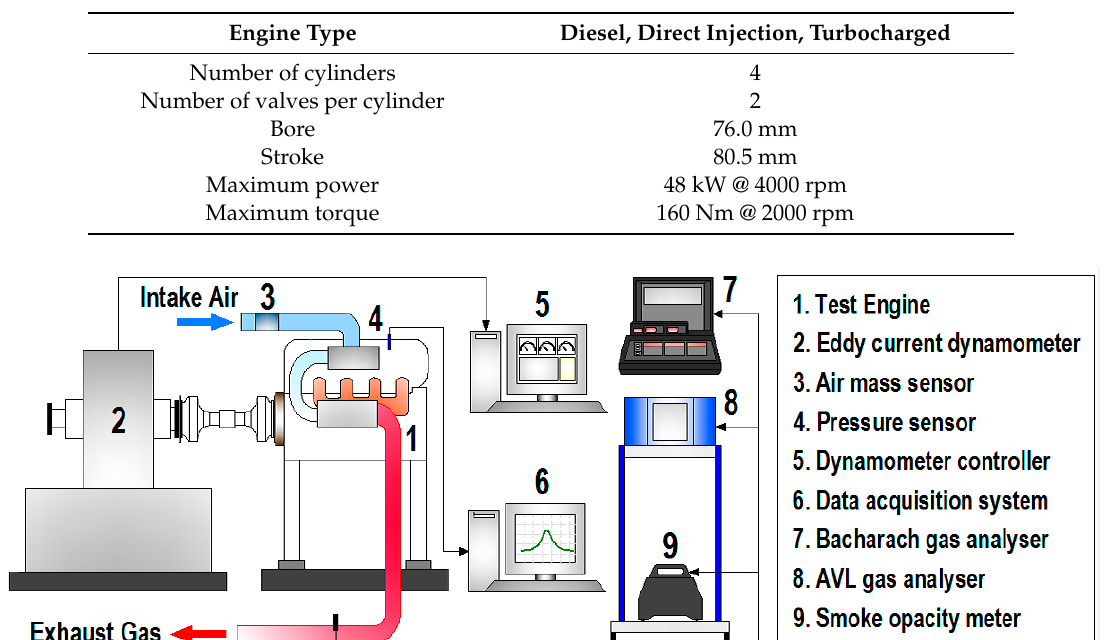
Figure 1 . Schematic diagram of the experiment setup. Figure 1. Schematic diagram of the experiment